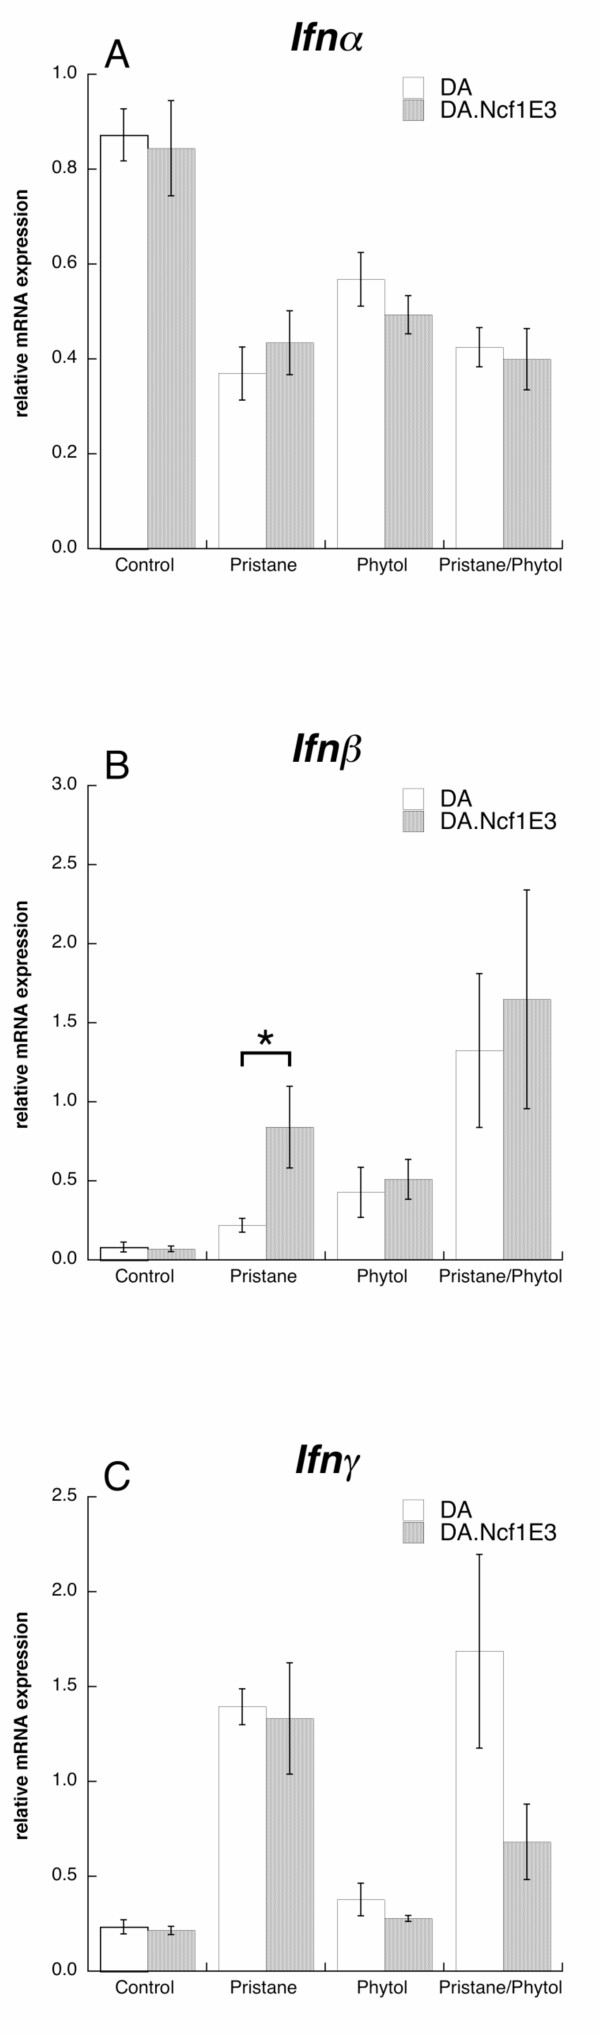
Gene-expression comparison between DA (open bars) and DA. Ncf1E3 (filled bars) of (A) Ifnα, (B) Ifnβ and (C) Ifnγ in inguinal lymph nodes 10 days after injection. Values are means ± SEM of 4–5 animals per group. Levels of significance between the strains were calculated using Student's t-test (*p < 0.05).